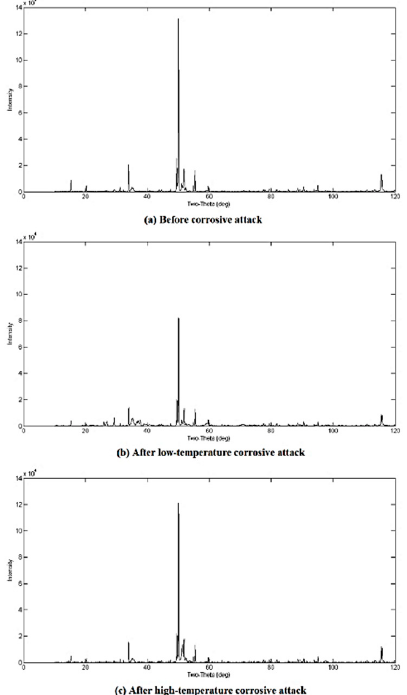
Figure A31. Qualitative XRD analysis of the surface of 316-A-Z ( a ) before corrosive attack, ( b ) after low-, and ( c ) high-temperature corrosive attack.